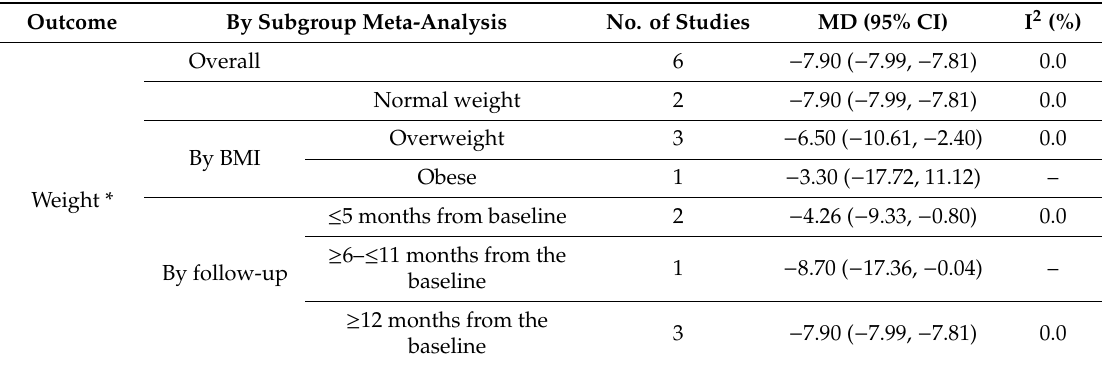
Table 3. Meta-analysis comparing CR regimens with control: mean di ff erence (MD) 95% CI and I-squared percentages for weight, fat mass and body mass index